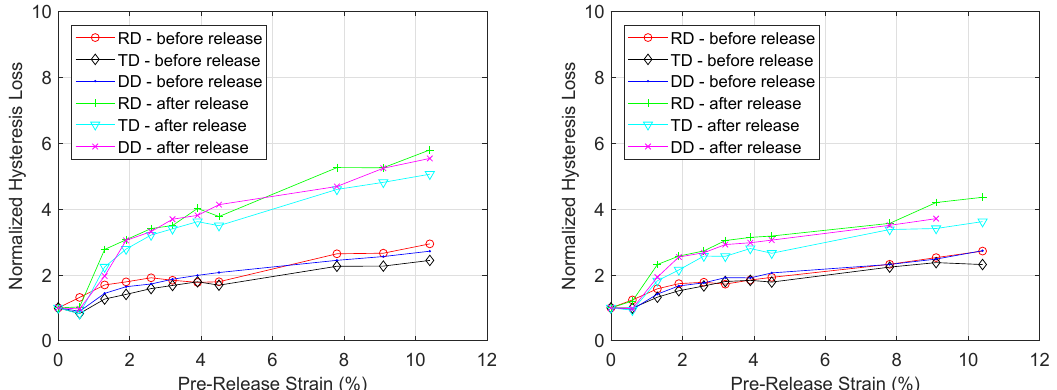
Figure 10. Evolution of hysteresis losses under increasing levels of strain at B p = 0.4 T ( left ) and at B p = 1.2 T ( right ). The results are normalized with respect to the hysteresis losses before plastic deformation.